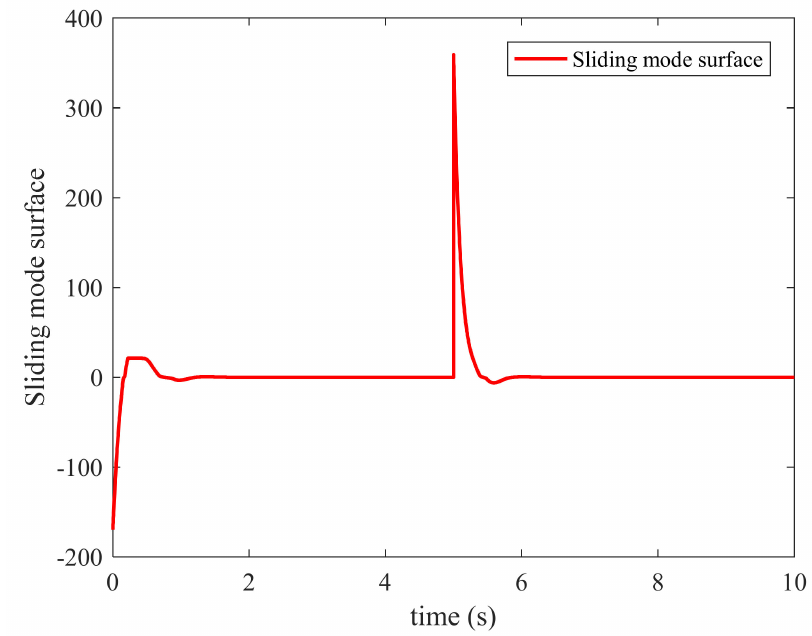
Figure 10. Time response of sliding mode